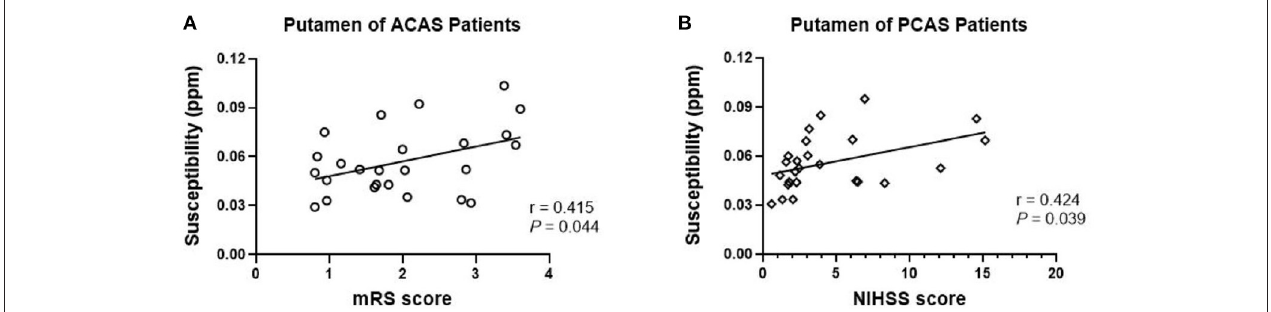
FIGURE 3 | Partial correlation analysis between mean susceptibility at bilateral putamen (PU) with NIHSS and mRS scores, adjusted for age. (A) In anterior circulation artery stenosis (ACAS) patients, mean susceptibility of bilateral PU was significantly increased with mRS score ( r = 0.415, P = 0.044); (B) In posterior circulation artery stenosis (PCAS) patients, mean susceptibility of bilateral PU was significantly increased with NIHSS score ( r = 0.424, P = 0.039).